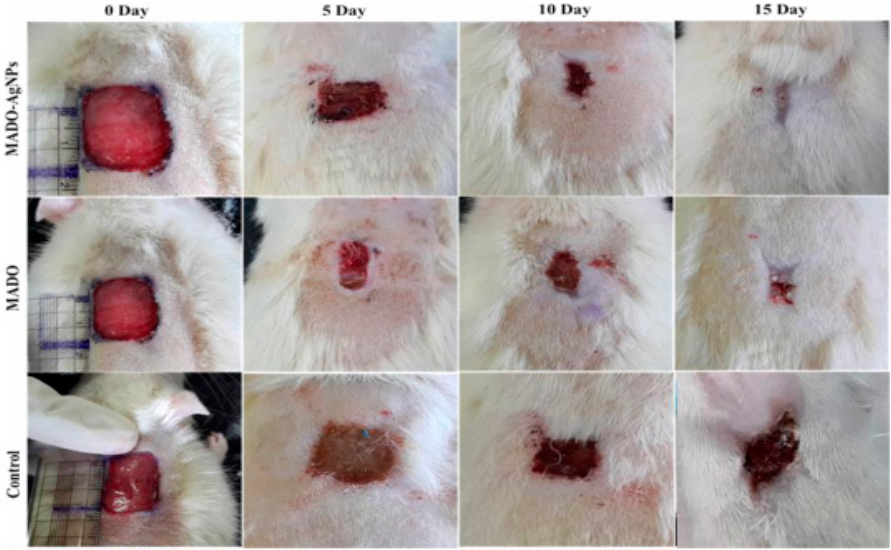
Figure 7. Wound appearance at 0, 5, 10 and 15 days after grafting with poly(dopamine methacrylamide-co-methyl methacrylate) (MADO)-AgNPs, MADO NF, and control [163].